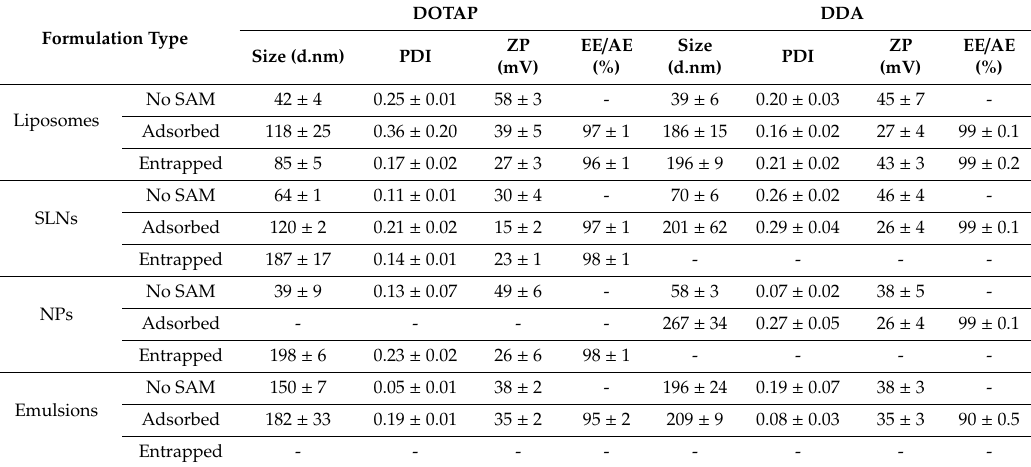
Table 1. Physico-chemical properties of cationic lipid-based delivery systems. All formulations were prepared at 1 mg / mL final cationic lipid concentration. Results are represented as mean ± standard deviation (SD) of three independent batches of each formulation.